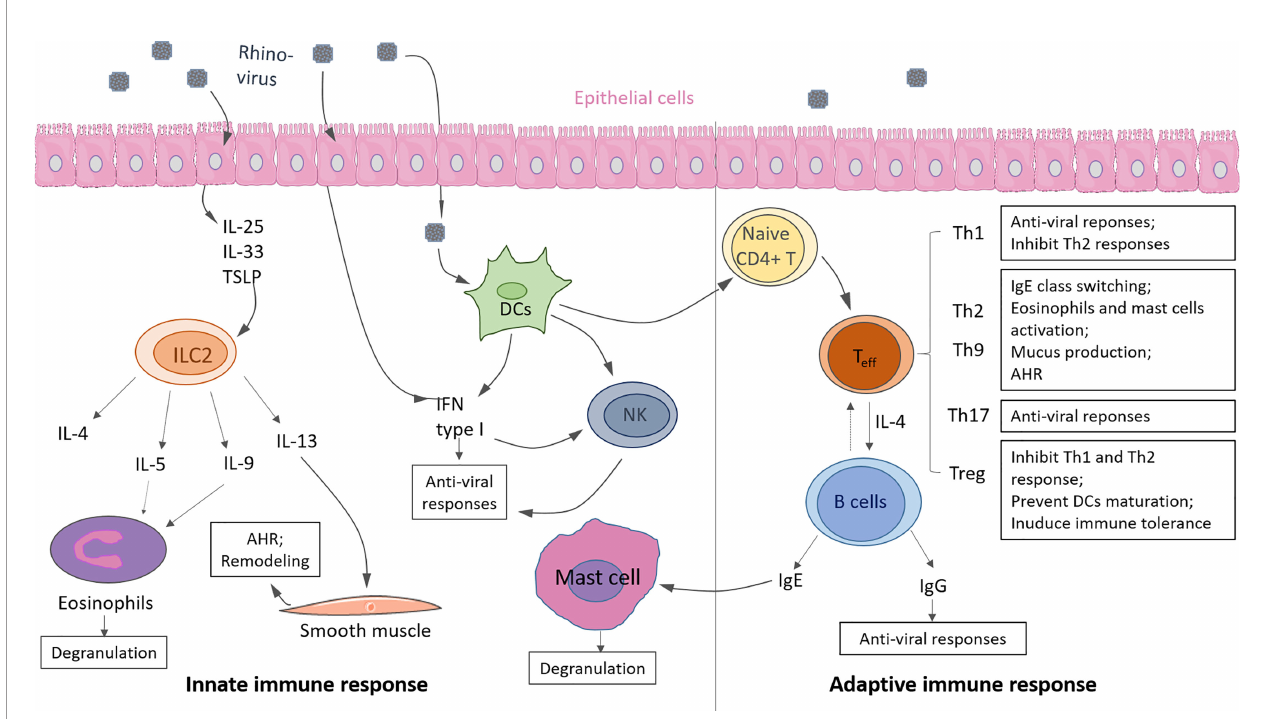
FIGURE 3 | Innate and adaptive immunity in response to rhinovirus (RV) infection in asthma. Innate immunity: Upon RV infection, epithelial cells produce cytokine IL-25, IL-33, TSLP, which promote ILC2 expansion and activation. Type 2 cytokines (i.e., IL-4, IL-5, IL-9, IL-13) are released by activated ILC2, resulting in eosinophils activation and degranulation. Infected epithelium cells, DCs, and DC-activated natural killer cells (NK) produce IFN type I induce anti-viral responses. Adaptive immunity: Activated DCs drive naive CD4+ T cells to differentiate into effector T cells (T eff ), such as Th1, Th2, Th9, Th17, Treg. T cells can eliminate viruses from the host by releasing anti-viral cytokines or promoting antibody class switching on B cells. IgE causes mast cell activation, and IgG causes viral clearance. Some of the displayed cells were provided by Smart Servier Medical Art